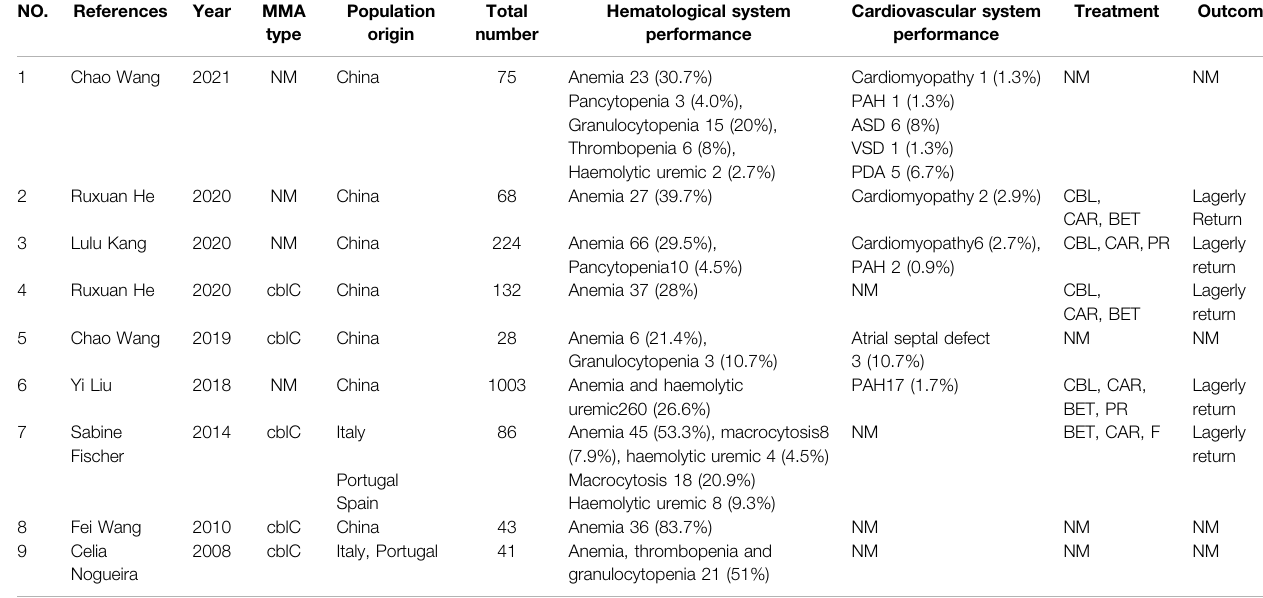
TABLE 1 | Multi-case analysis of MMA with cardiovascular and hematological